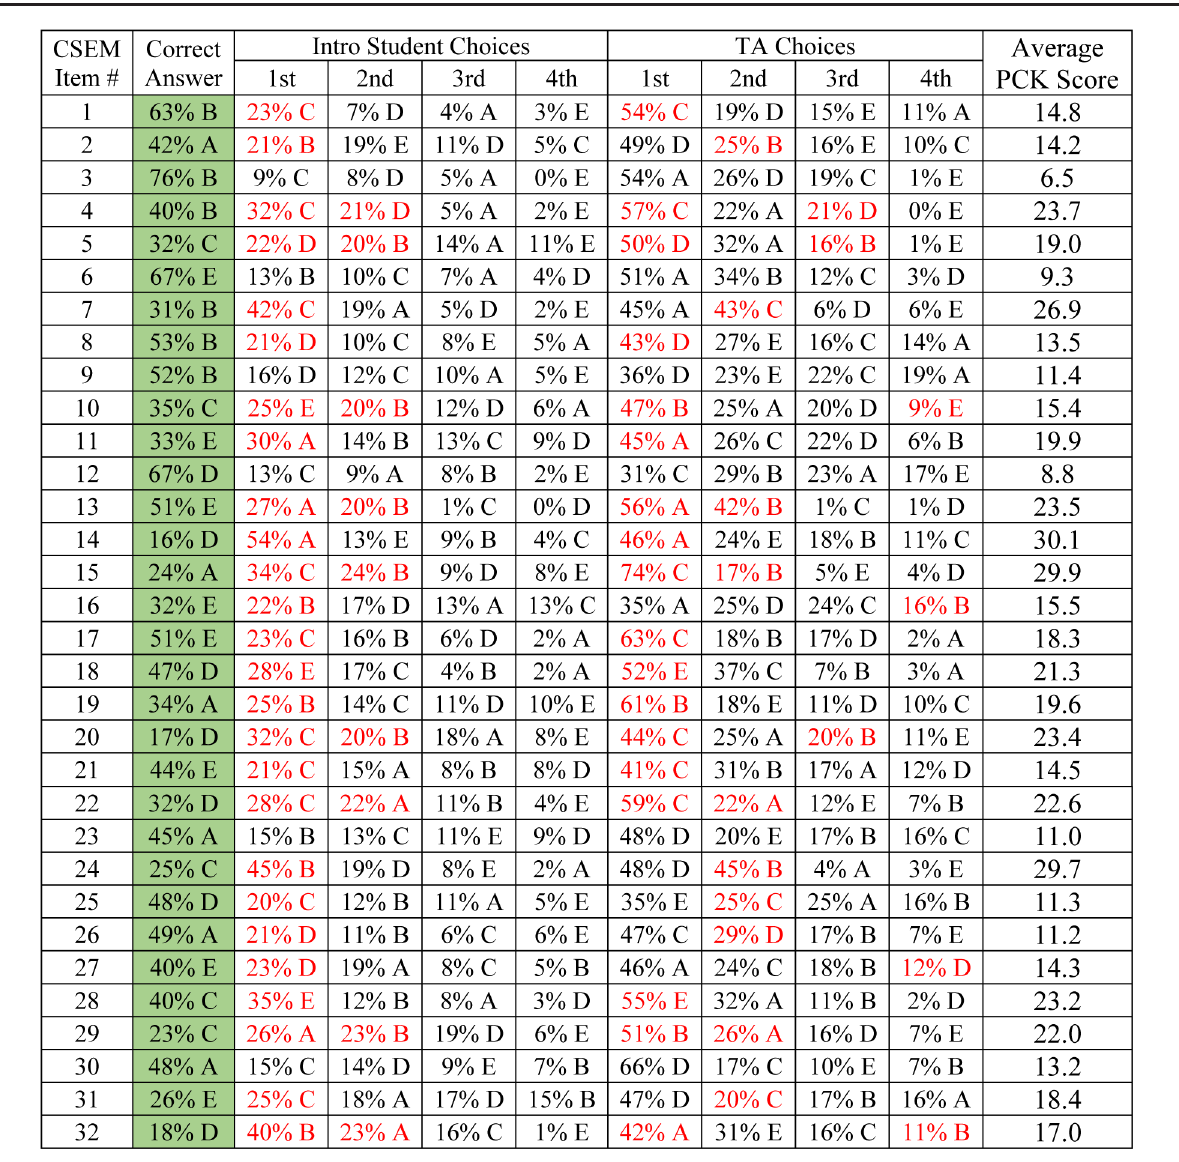
TABLE I. Questions on the CSEM, percentages of algebra-based students who answered the questions correctly in a post-test, percentages of students who selected each incorrect answer choice ranked from most to least common, the percentage of TAs who selected each incorrect answer choice as the MCI, and average PCK score. To help make the table easier to interpret, answer choices selected by 20% or more students are written in red font. The same answer choices are also written in red font for the TAs. Note that the data were taken from Ref. [23] and the number of students who answered each question varies from 158 to 444. With the exception of four questions, all questions were answered by more than 350 students in the